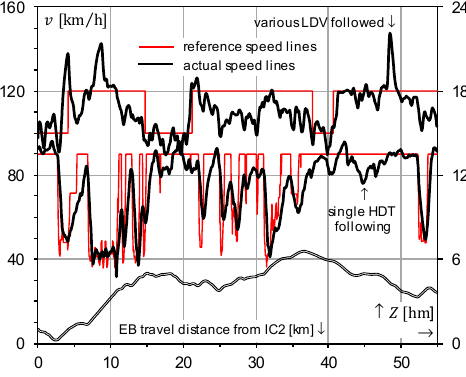
Figure 4. Reference driving-cycles and actual measured speed profiles.